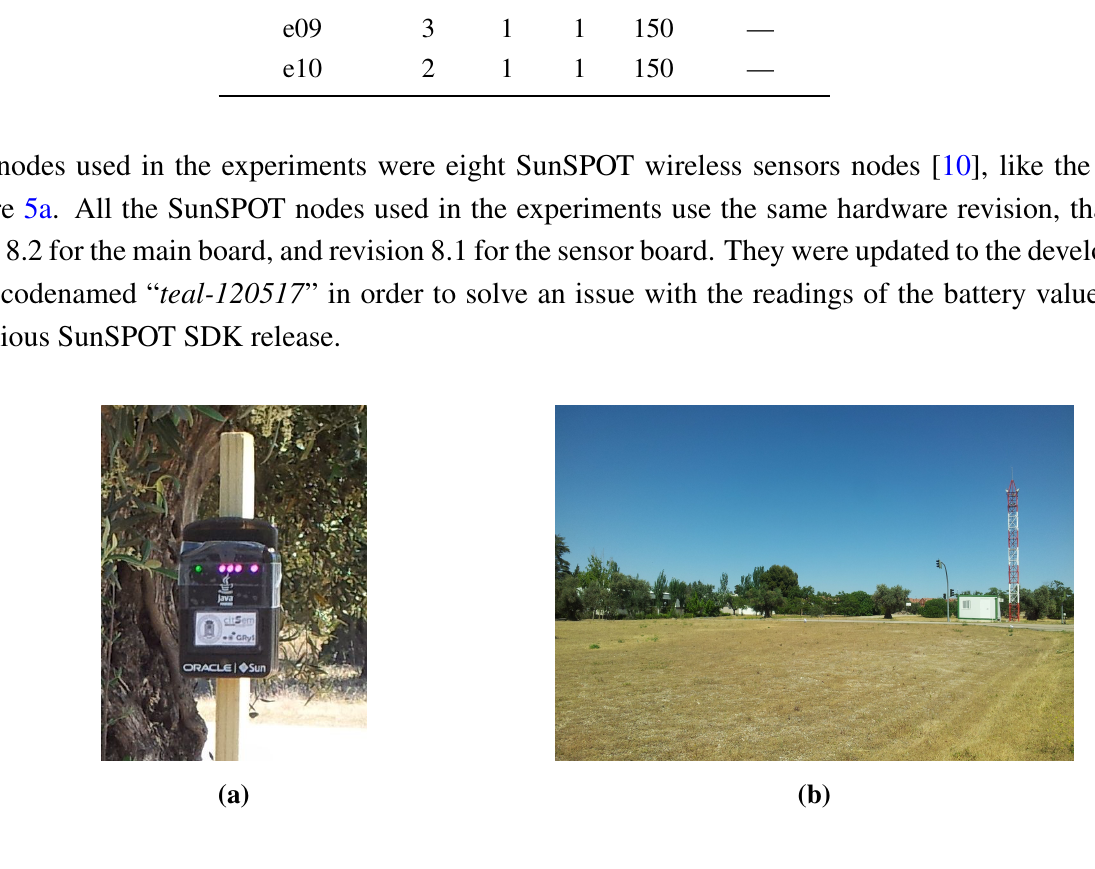
Figure 5. Experiment deployment; ( a ) One of the sensor nodes used in the experiments; ( b ) Deployment